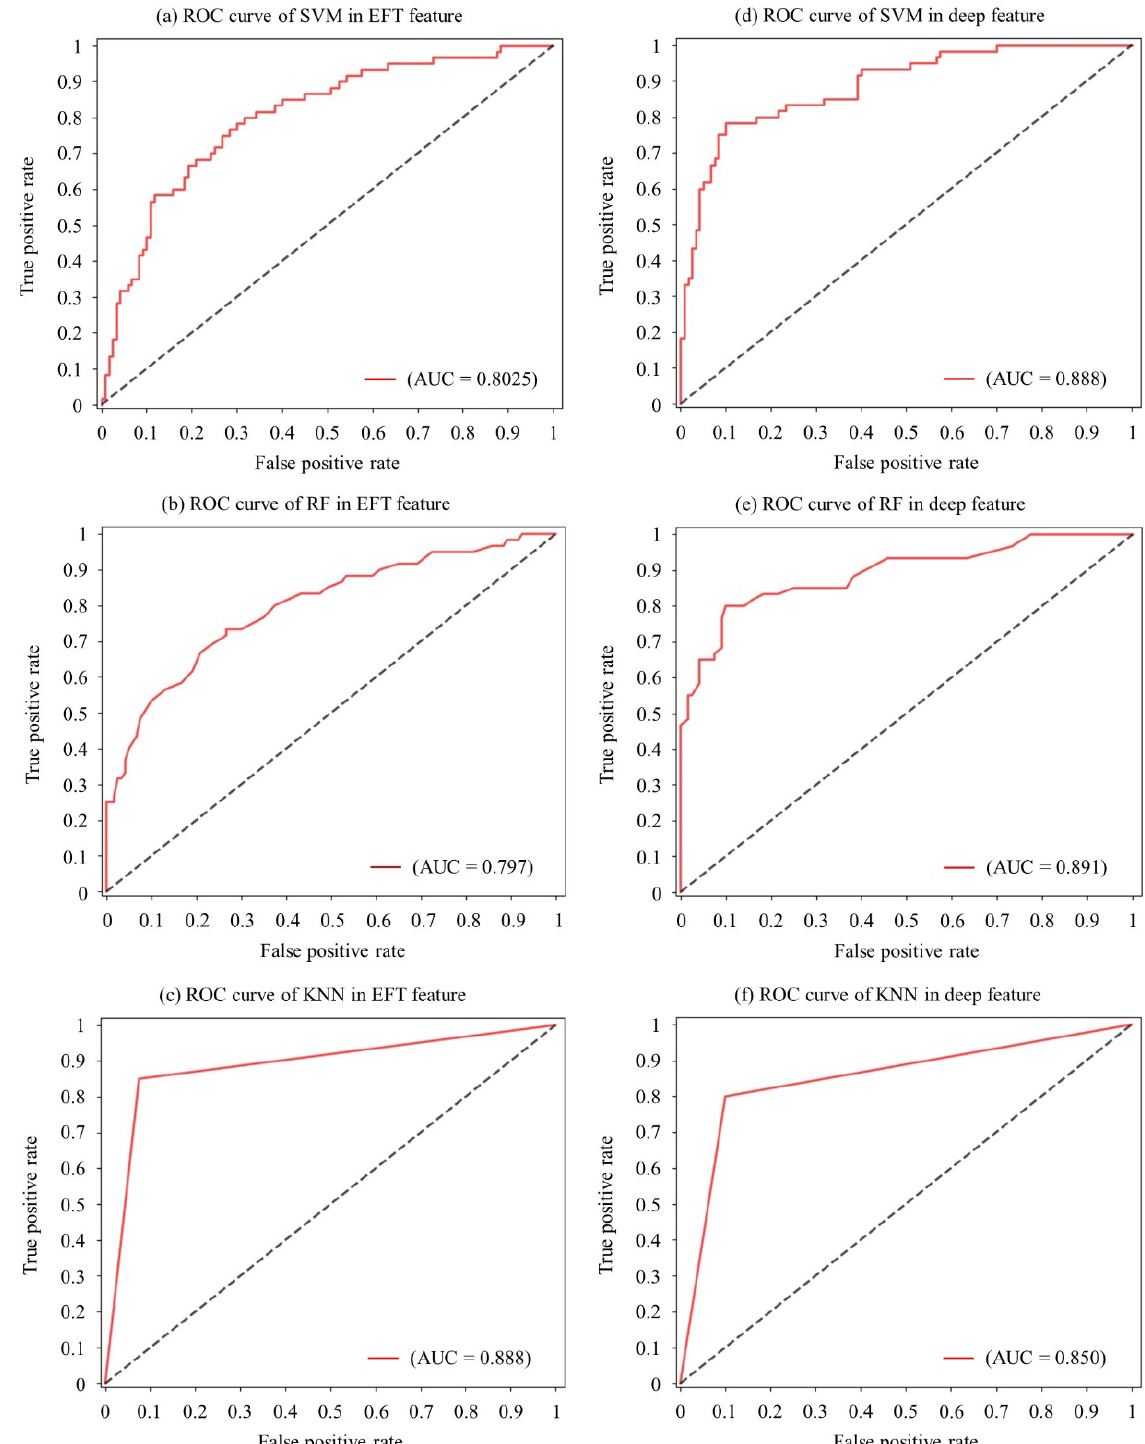
Figure 7. ROC curves and AUC values for different machine learning algorithms: from ( a ) to ( c ) is EFT feature; from ( d ) to ( f ) is deep features ; ( a ) and ( d ) represent SVM; ( b ) and ( e ) represent RF; ( c ) and ( f ) represent KNN. The red curve represents the average ROC curve of the three tuna species.